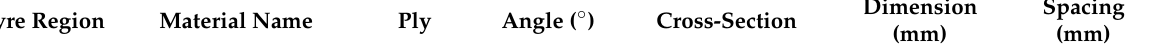
Table 3. Geometric dimensions of the composite structure of the DTA 275/80R22.5-type